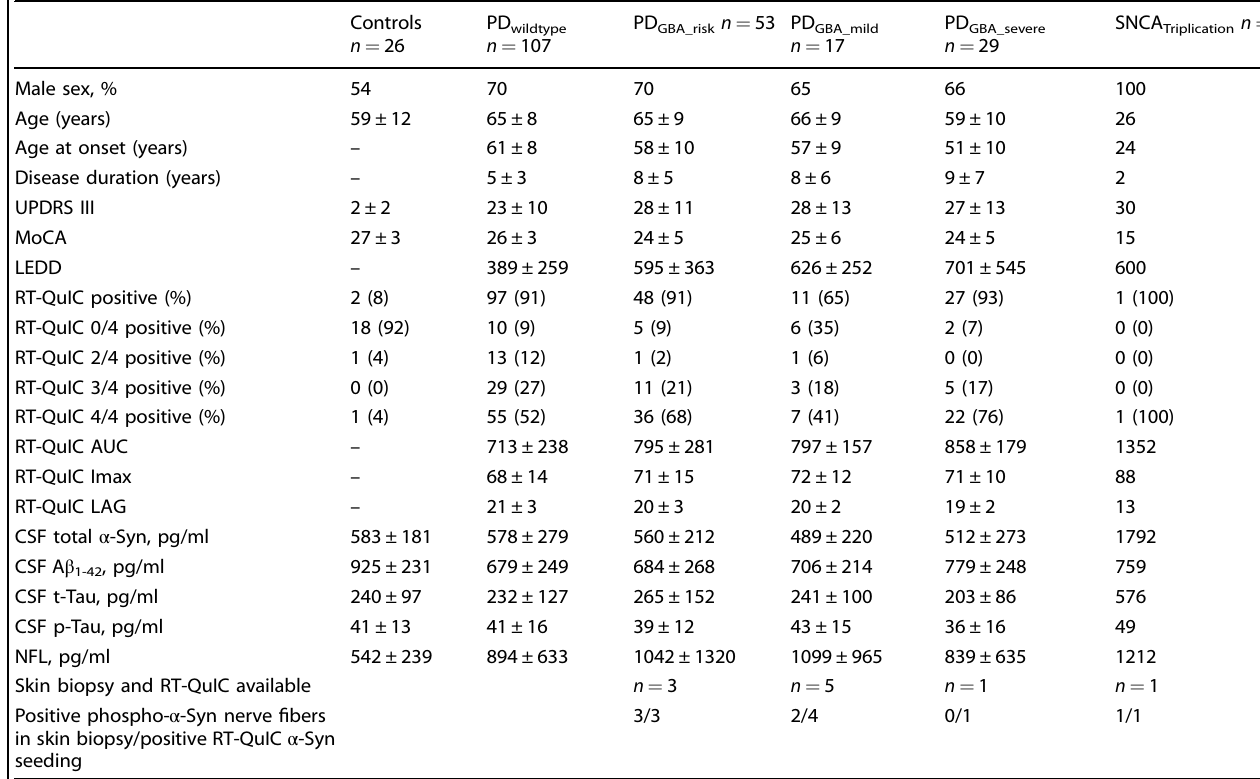
Table 1. RT-QuIC seeding pro fi les in PD strati fi ed by mutation status.